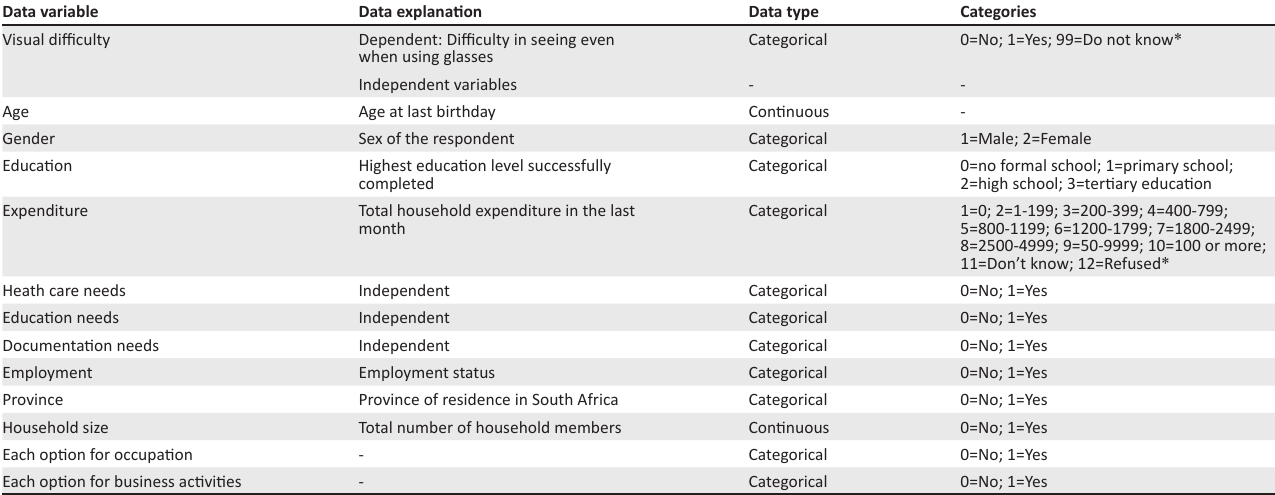
TABLE 1: Operational definitions of variables. Data